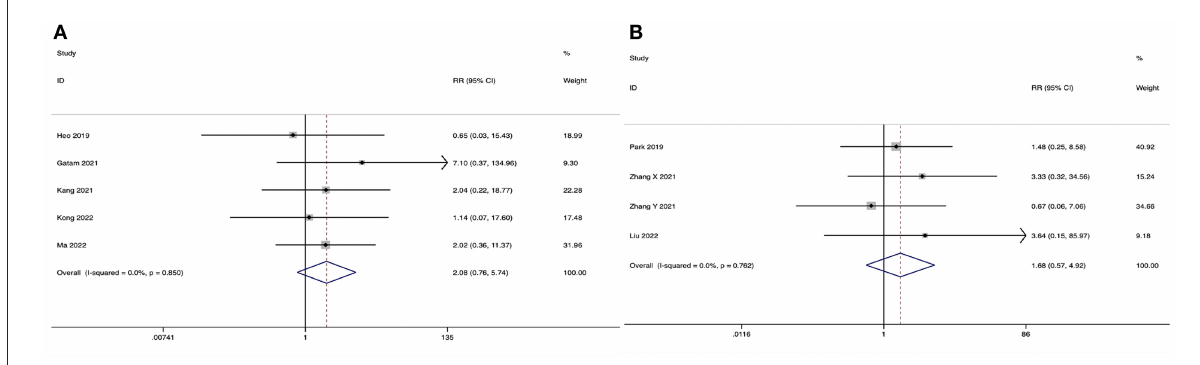
FIGURE11 Forest plot of the incidence of dural tear. (A) ULIF vs. MI-TLIF; (B) ULIF vs. PLIF.